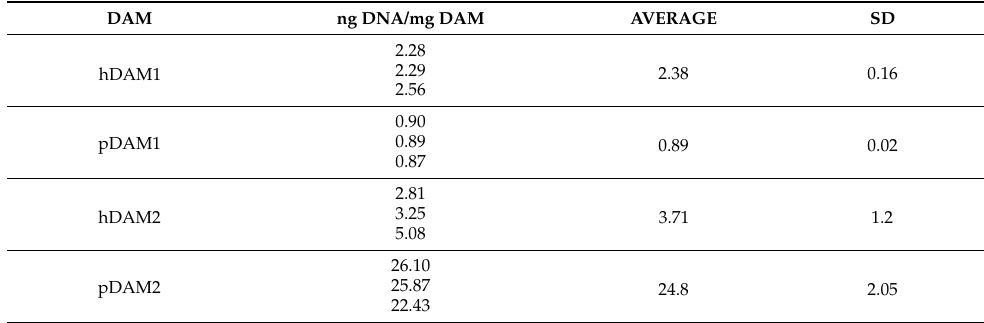
Table 1. Remnant DNA quantity (ng DNA/mg DAM dry weight) after tissue decellularization in all assayed decellularized adipose matrices